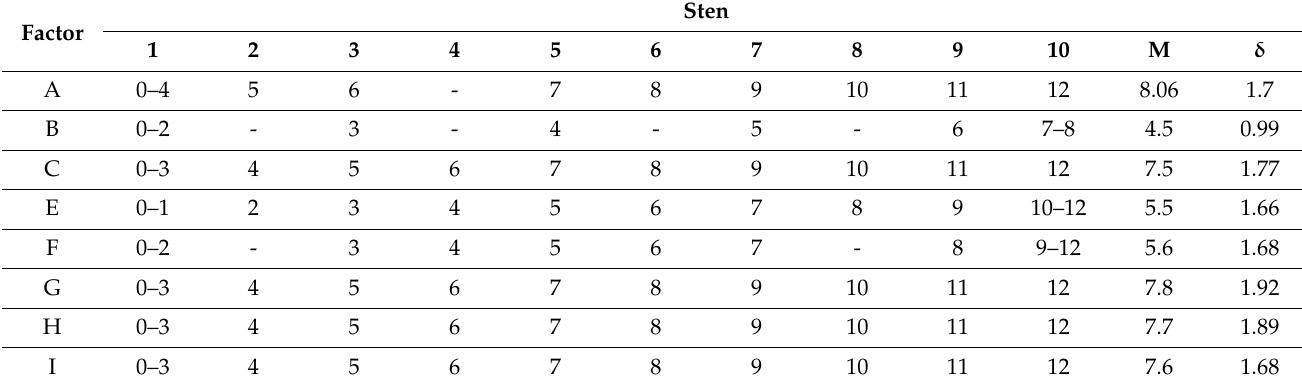
Table 3. Standard score conversion